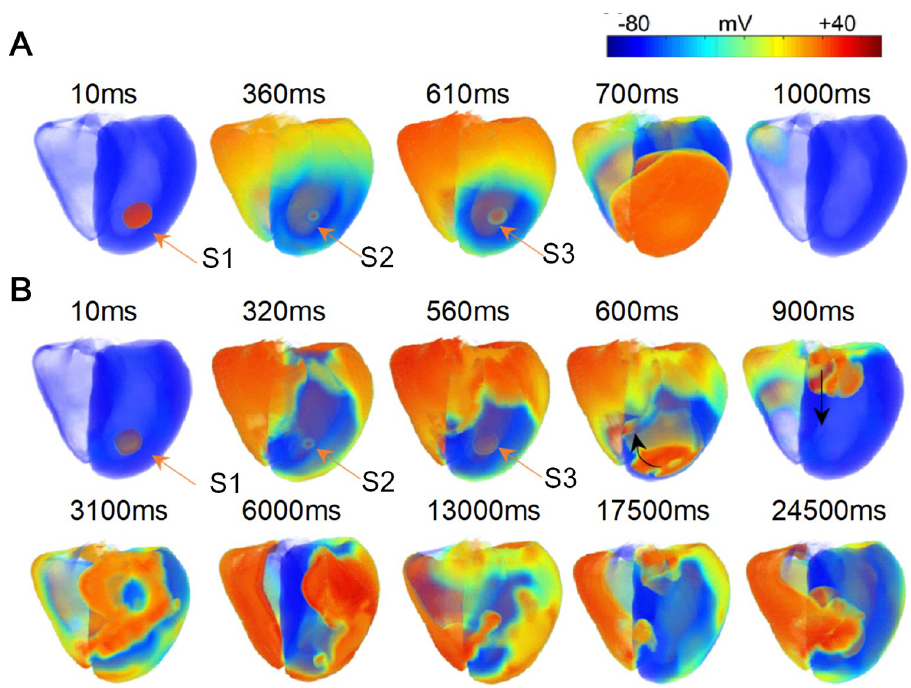
Fig 9. Wave propagation in the 3D ventricular tissue where three stimuli were applied on a small cubic tissue with the size of 10 × 10 × 10nodes in intramyocardial region. (A) Wave propagation in the 3D ventricular tissue in normal conditions without MI scars. The S1, S2 and S3 stimuli were applied at 0ms, 350ms and 600ms, interval 350ms and 250ms, respectively. (B) Wave propagation in the 3D ventricular tissue with a scar containing ischemia 1a, 1b, and MI areas (see Fig 1B). The S1, S2 and S3 stimuli were applied at 0ms, 310ms and 550ms, interval 310ms and 240ms,